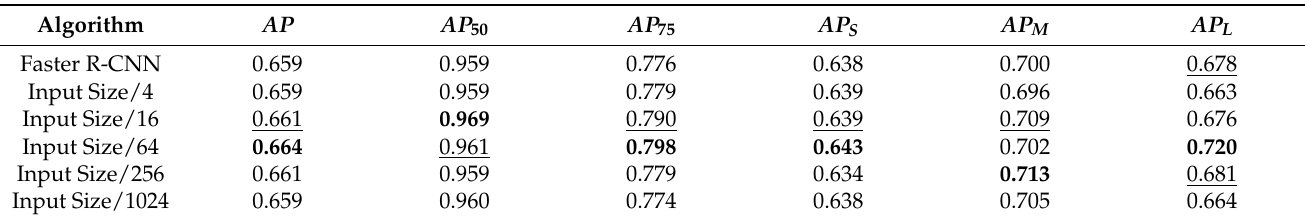
Table 10. Experimental results of different size weighting maps. Bolded data represent the best and underlined data represent the second